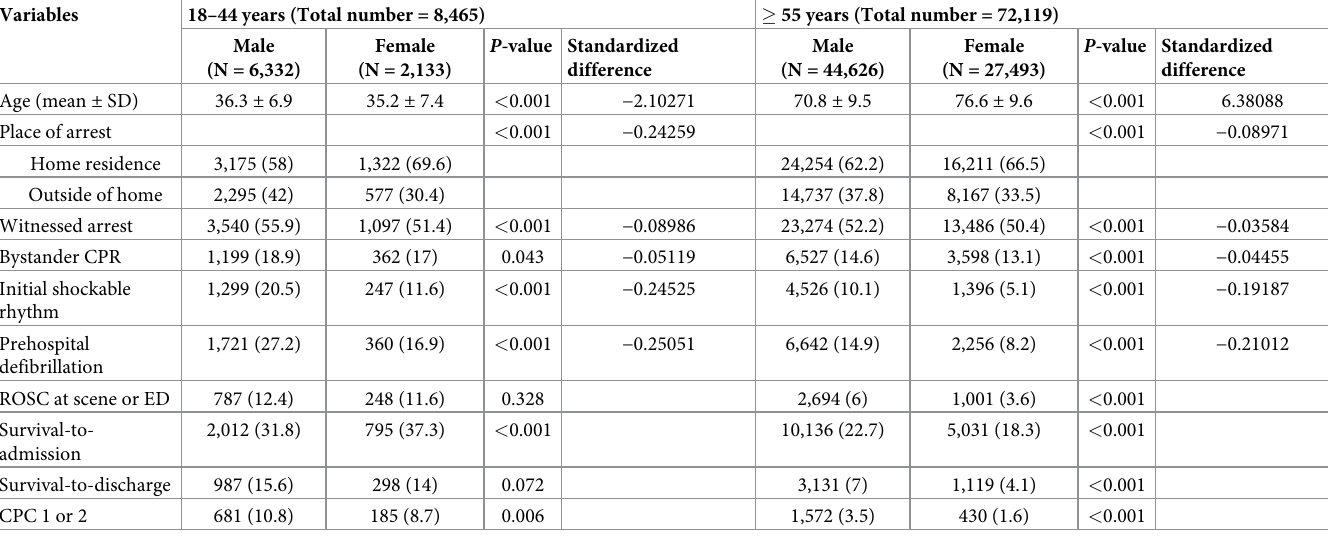
Table 2. Characteristics of patients with out-of-hospital arrest by age group and sex.